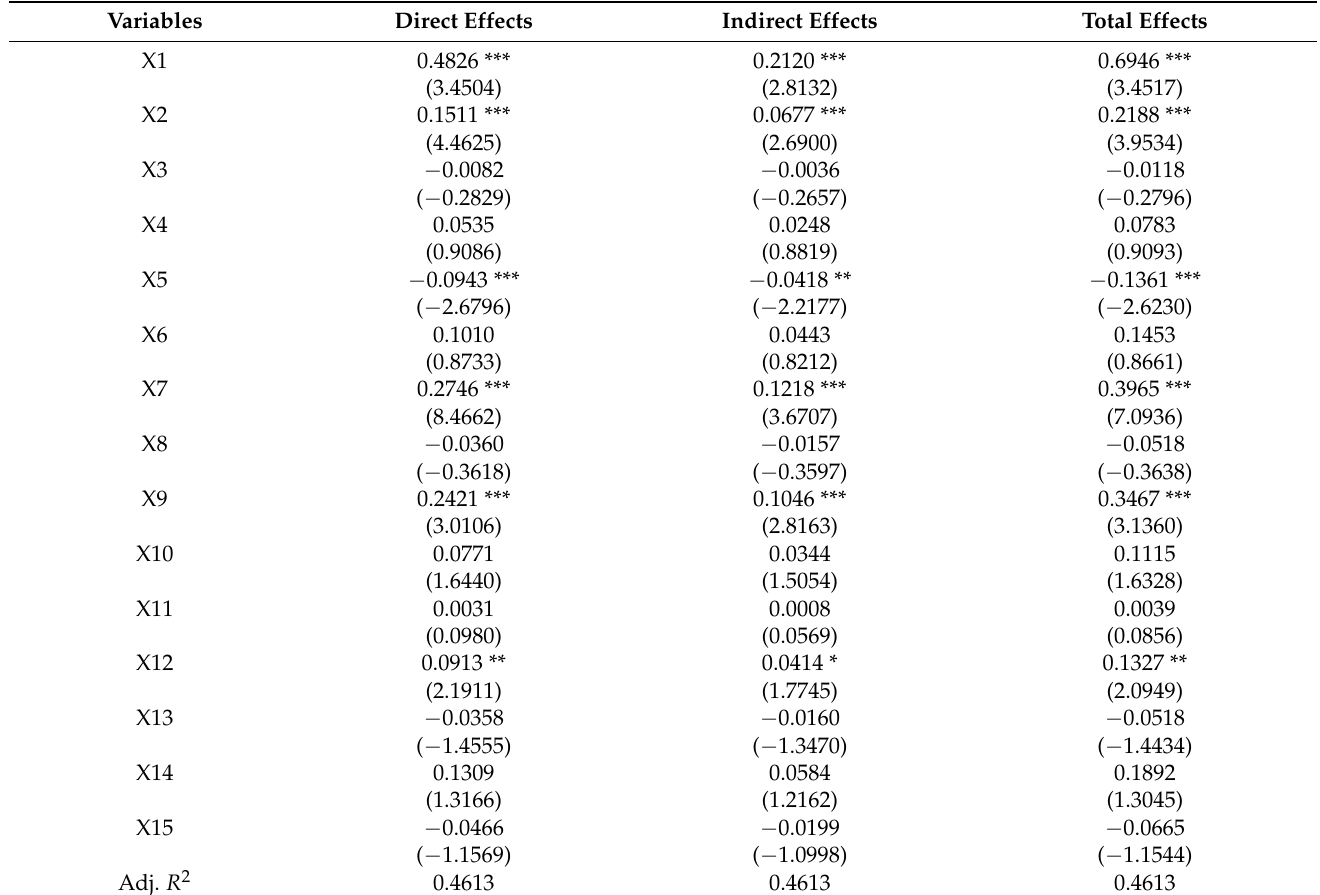
Table 6. Results of the direct, indirect, and total